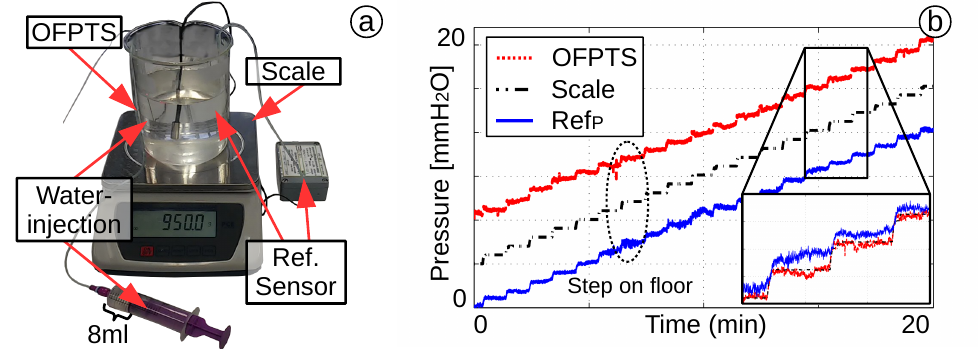
Figure 13. ( a ) Beaker with OFPTS, MPXV7002 reference sensor and scale; ( b ) increased pressure with successive 1-mm steps of water.